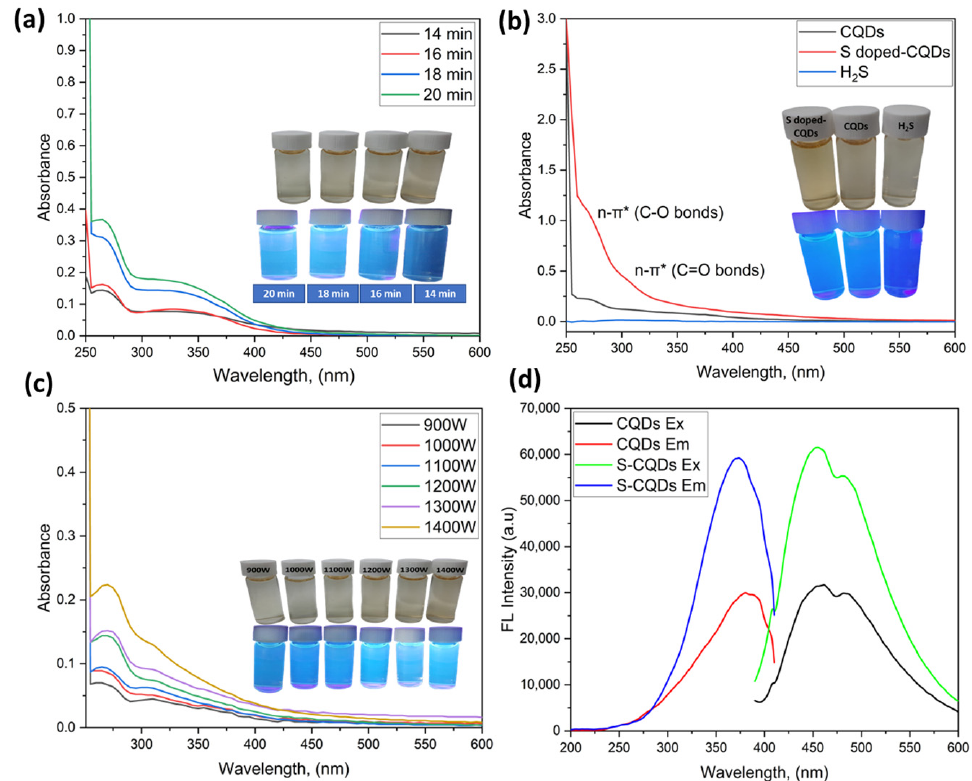
Figure 5. Synthesis optimization of S-CQDs: ( a ) Uv–Vis of the effect of heating time, ( b ) Uv–Vis of the effect of H 2 S on absorption of CQDs, ( c ) Uv–Vis of the effect of hydrothermal treatment (W), ( d ) FL Spectrophotometer of optimum condition (S/W:5/5).